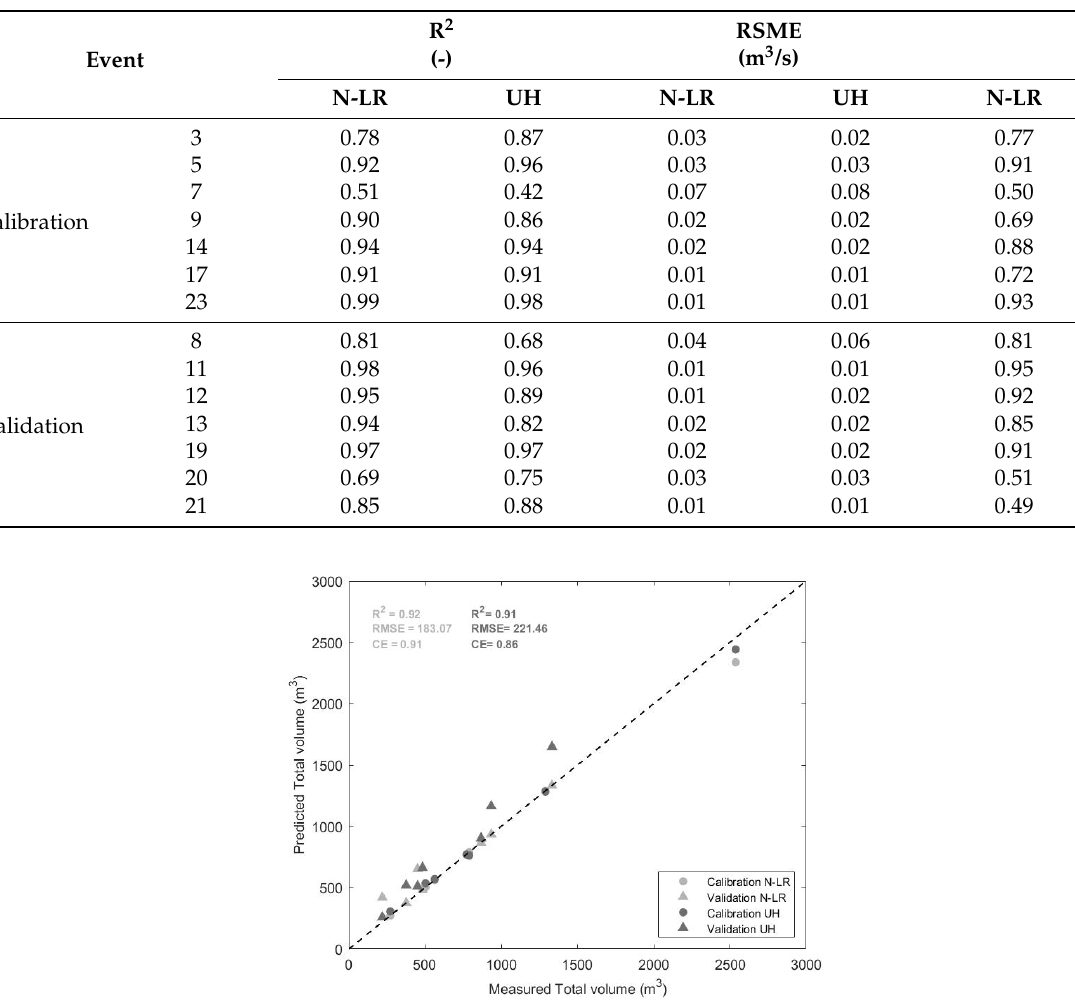
Table 5. Simulation results. The yellow color is used to highlight the performance of the better model.